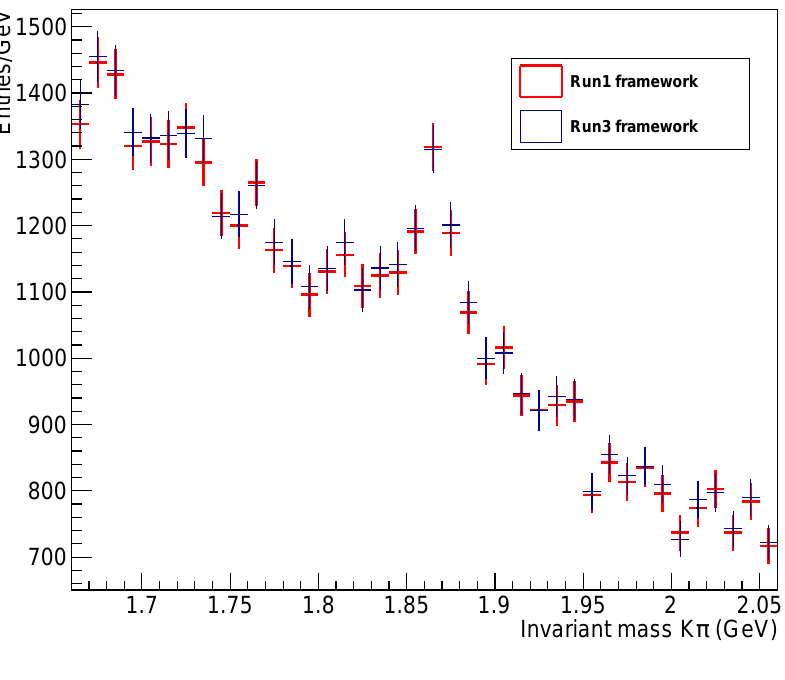
Figure 1. Invariant mass distribution of D 0 candidates from a Pb–Pb Monte Carlo simulation performed using the legacy Run 1 software and the new O2